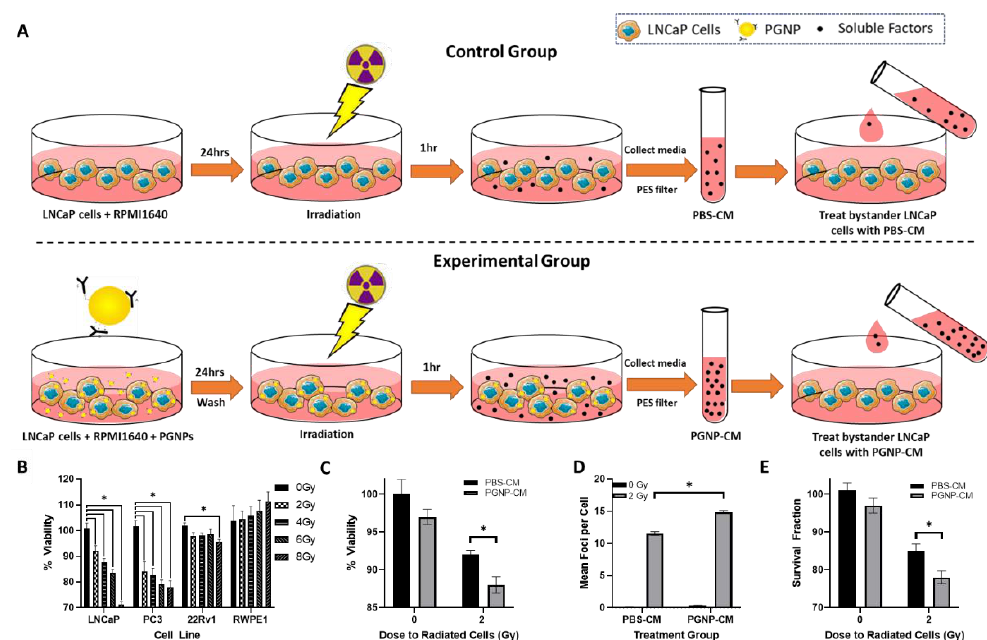
Figure 3. ( A ) Workflow of the conditioned medium transfer procedure for a RIBE response investigation. ( B ) MTT cell viability assays of LNCaP/PC3/22Rv1 (prostate cancer) and RWPE1 (normal prostate) bystander cells treated with PBS-CM extracted from their respective irradiated cell line cells under different radiation doses. ( C – E ) MTT cell viability, γH2AX, and clonogenic assays of bystander cells treated with 0 Gy-PBS-CM, 2 Gy-PBS-CM, 0 Gy-PGNP-CM, and 2 Gy-PGNP-CM. * Denotes p < 0.05 from Welch’s t-test.